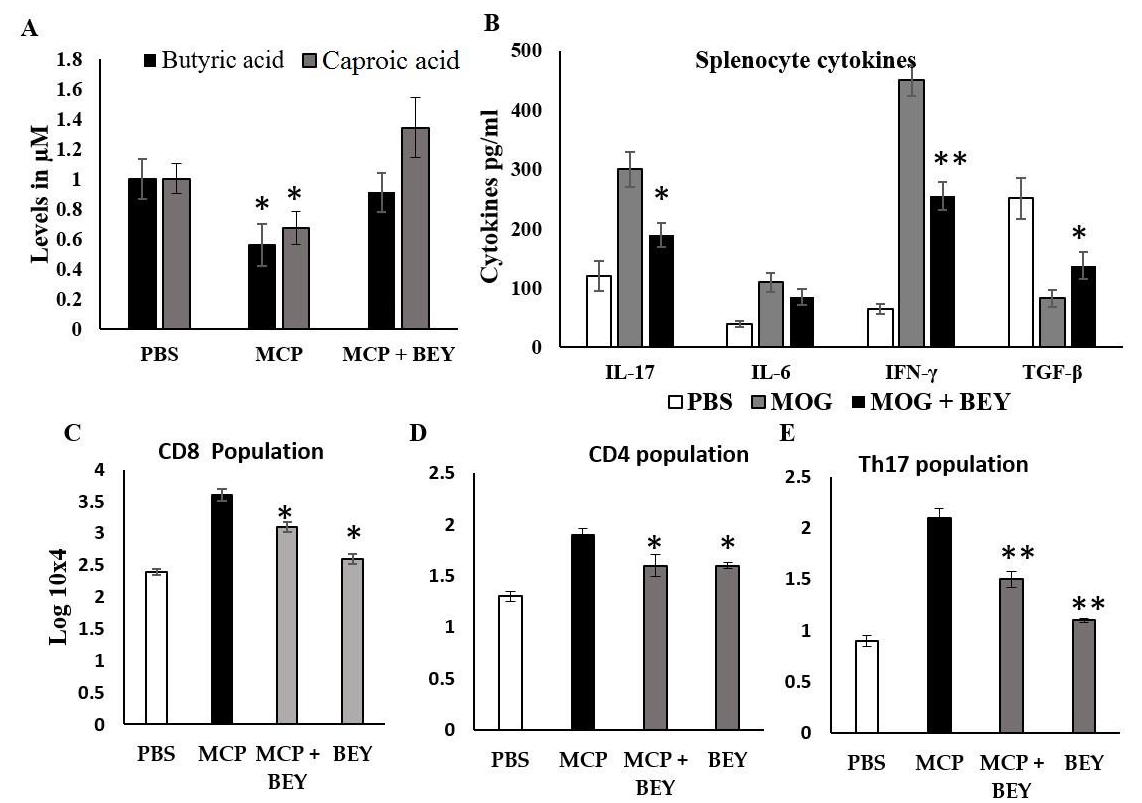
Figure 5 . Effect of BEY on biochemical and inflammatory modulators in MOG-induced EAE mice. The splenic cells from naïve mice were examined for SCFAs (short-chain fatty acids), cytokines and T-cell inflammatory cell population in spinal cord. ( A ) Butyric acid and caproic acid were quantified, and values are expressed in µM. ( B ) The expression levels of cytokines (IL-17, IL-6, IFN- γ and TGF- β ) were estimated using ELISA Kit (Invitrogen, CA, USA; Biovision, Abcam, USA). ( C – E ). CD4, CD8 and Th17 cell populations were counted in spinal cord of BEY-treated EAE mice. For each group, values were expressed as mean ± SD. For statistical analysis, one-way ANOVA was used, followed by a post hoc t -test (significant at * p ≤0.05, ** p ≤ 0.01 ).